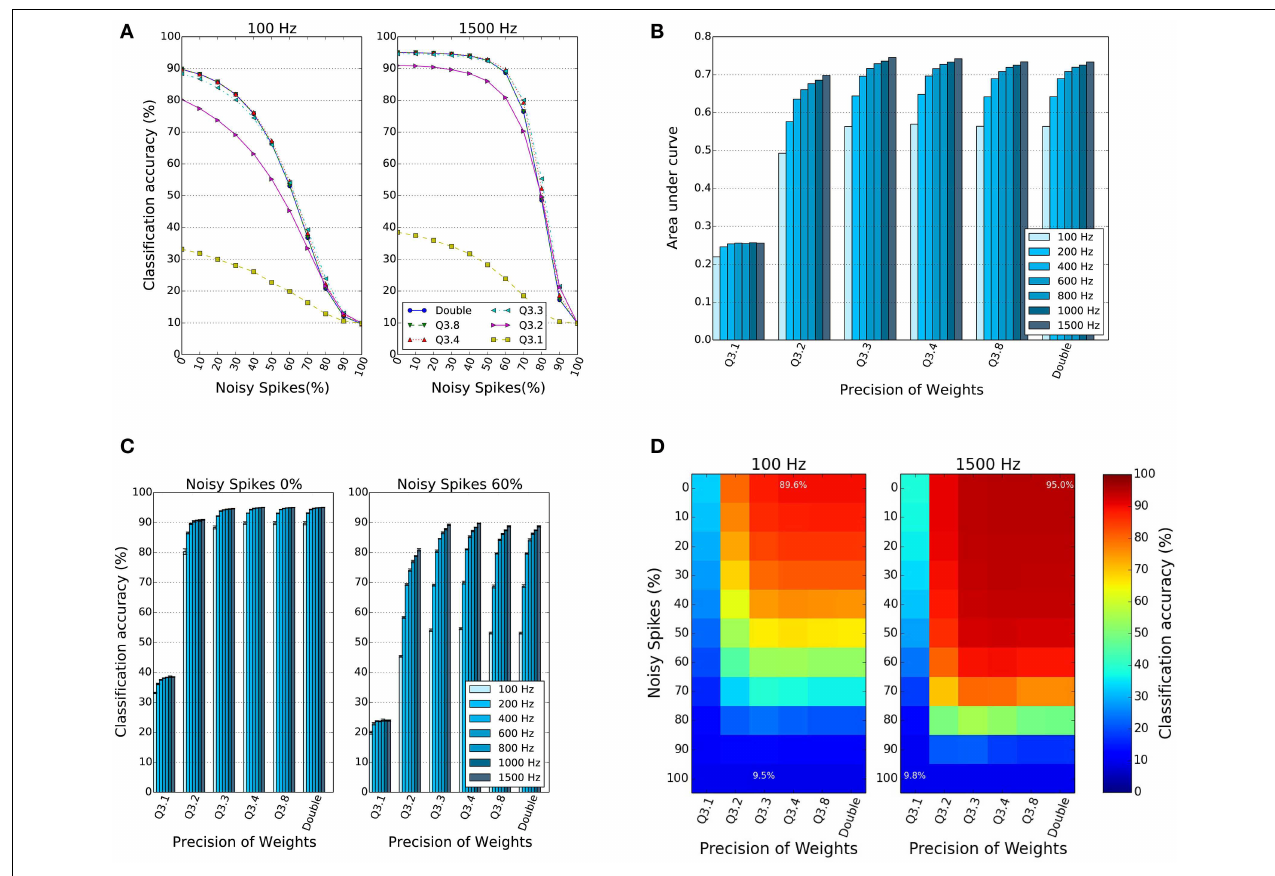
noise. (C) CA as a function of the weight bit resolution for different input firing rates and for two different noise levels, 0 and 60%. (D) CA as a 2D function of the bit resolution of the weights and the percentage of input noise for 100 and 1500Hz input rate. The results confirm that spiking DBNs with low precision weights down to f 3 bits can still reach high performance levels = and tolerate high levels of input